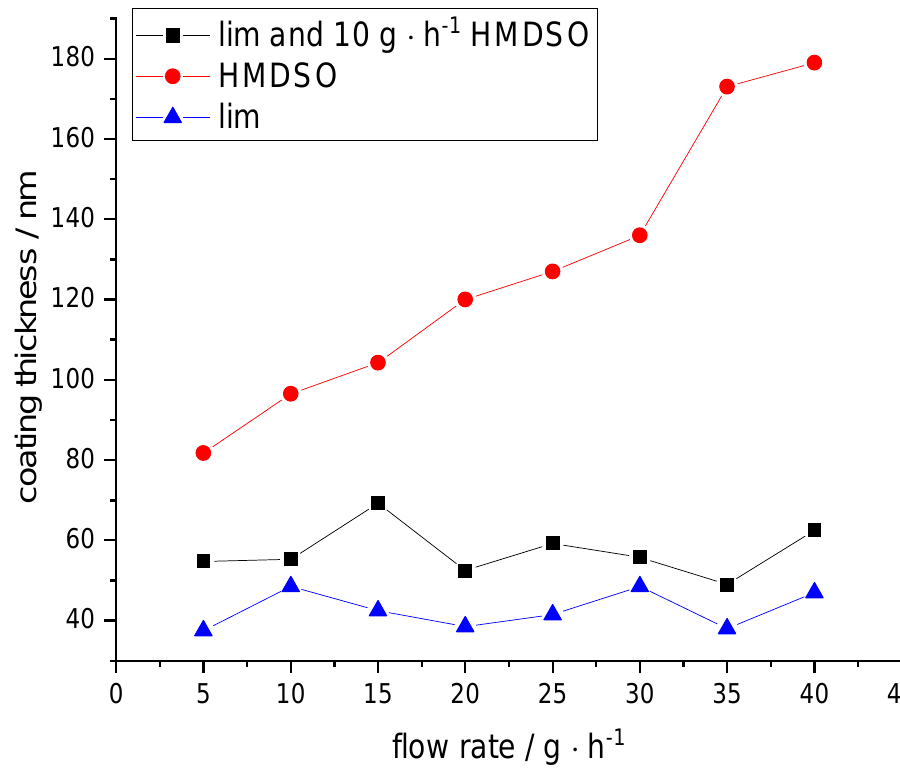
Figure 5. Coating thickness at different flow rates of homo-polymerization of (blue curve) lim; (red curve) HMDSO; (black curve) co-p of lim and HMDSO (at a constant flow rate of 10 g · h − 1 ). A further comparison of the different coating thicknesses of pp HMDSO, pp lim and co-p shows an interesting result. At a flow rate of 10 g · h − 1 , the coating thickness is 97 nm for pp HMDSO and 48 nm for pp lim. The co-p at the same flow rates (10 g · h − 1 each for HMDSO and lim) has a thickness of only 55 nm. This experimental value is significantly lower than the calculated theoretical sum of the coating thickness of 145 nm obtained by adding the individual thicknesses of both